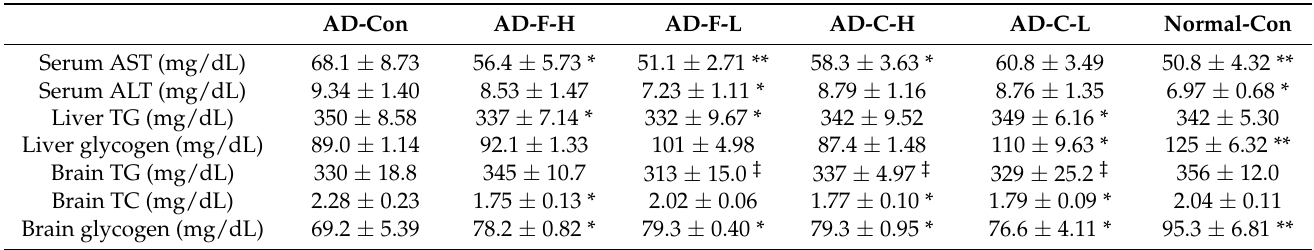
Table 2. Serum AST and ALT concentrations and triglyceride and glycogen contents in the liver and brain. AD-Con